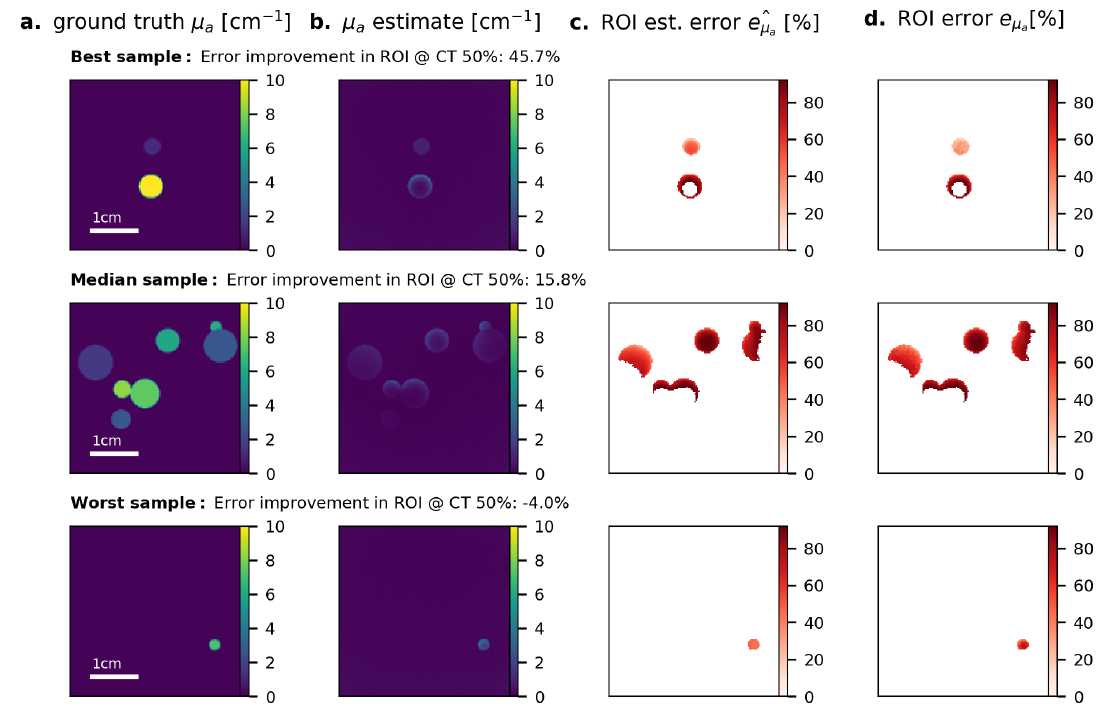
Figure A1. Sample images showing the best, the worst, and the median performance of our method when considering only the 50% most confident quantification estimations. All images show the ( a ) ground truth absorption coefficients ( b ) reconstructed absorption, ( c ) error estimate from external model, ( d ) the actual quantification